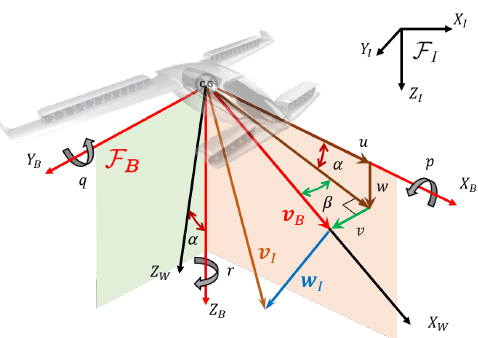
Figure 4. Representation of inertial and body reference frames with positive flow angles ( α , β ), linear relative velocities ( u , v , w ), angular rates ( p , q , r ) and the velocity triangle between inertial velocity v I , the relative velocity v B and the wind velocity w I